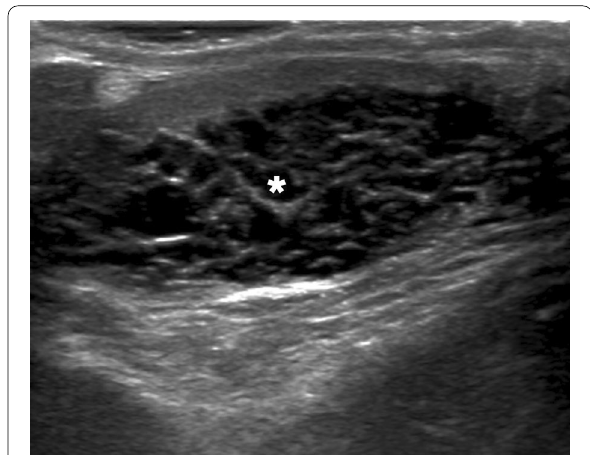
Fig. 19 Tubular ectasia of rete testis. A 57-year-old male with a history of bilateral vasectomy now presenting with a right testicular mass. Physical exam revealed bilateral small testes with a questionable palpable mass on the right side. Gray scale US image demonstrates multiple cystic-tubular anechoic structures completely replacing the mediastinum testis (asterisk) in the right. There were also similar findings in the left testis, to a lesser extent (not shown). Based on patient’s history the findings are consistent with extensive rete testis ectasia in the right testis. Follow-up imaging studies demonstrated stability of the findings over 2 years (not shown)